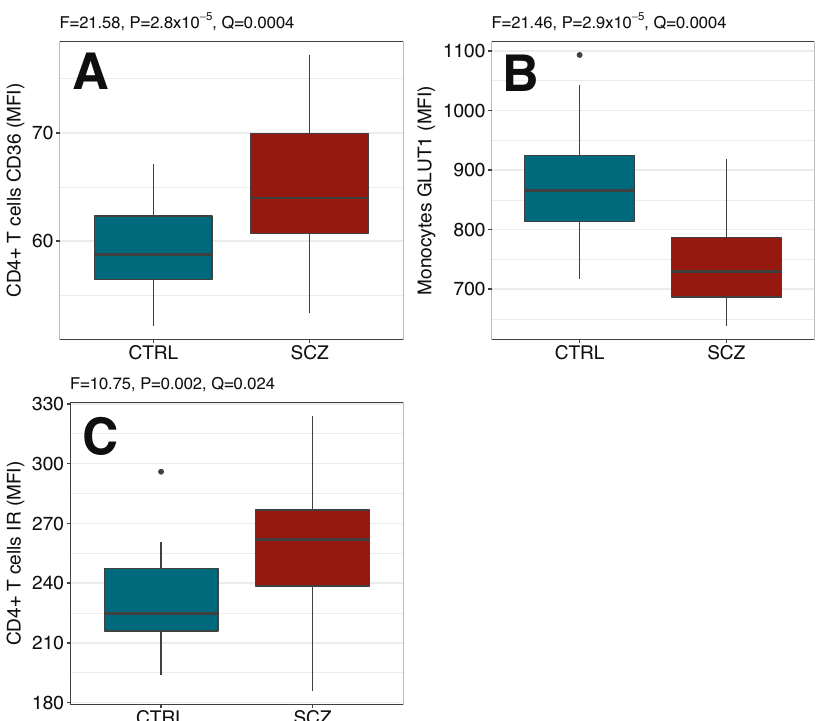
Fig. 1 Biomarkers of schizophrenia. Shown are signi fi cant ( Q < 0.05) results from the ANCOVA analysis of blood biomarker data in the recent- onset schizophrenia (SCZ, red) and healthy control (CTRL, cyan) groups from the original cohort. Y-axes show median fl uorescence intensity (MFI) of metabolic marker staining in PBMC subtypes, including fatty acid translocase (CD36) expression in T helper cells ( A ), glucose transporter 1 (GLUT1) expression in monocytes ( B ), and insulin receptor (IR) expression in T helper cells ( C ). Boxplots represent the median, interquartile range, and minimum and maximum values, excluding outliers (dots). The analysis was adjusted for batch effects, cell counts, age, smoking, education and childhood